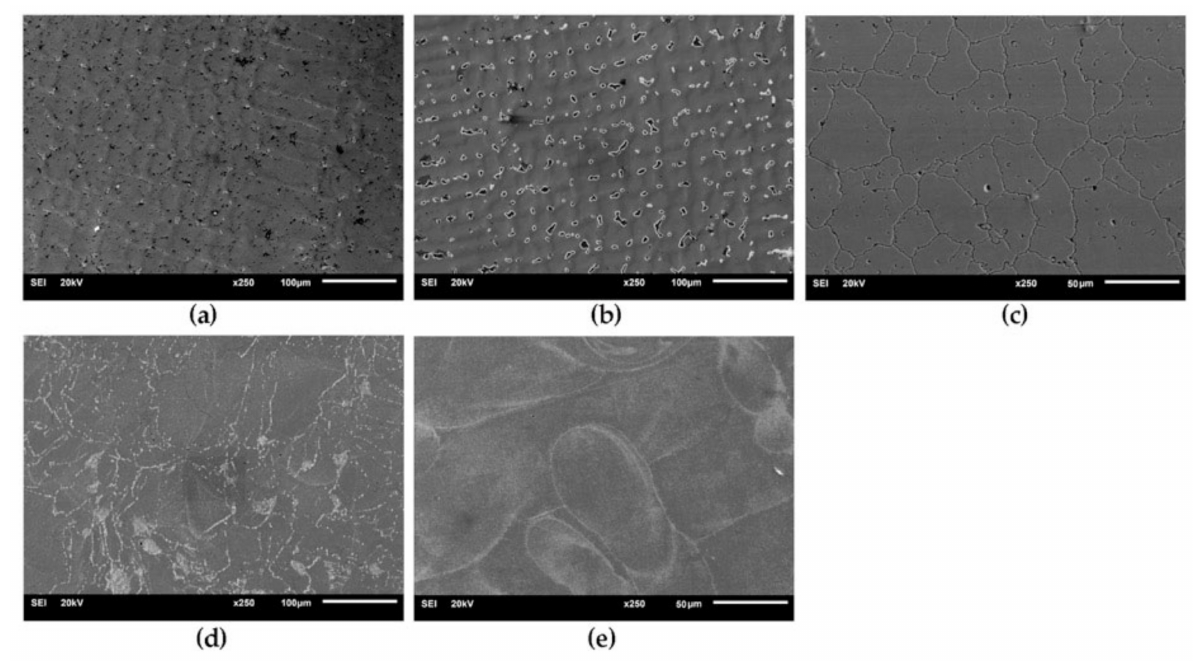
Figure 1. SEM-SE (Secondary Elctrons) images of the Co–Cr alloys before the heat treatment (HT). ( a ) CST1; ( b ) CST2; ( c ) MSM; ( d ) SLM1; ( e ) SLM2.